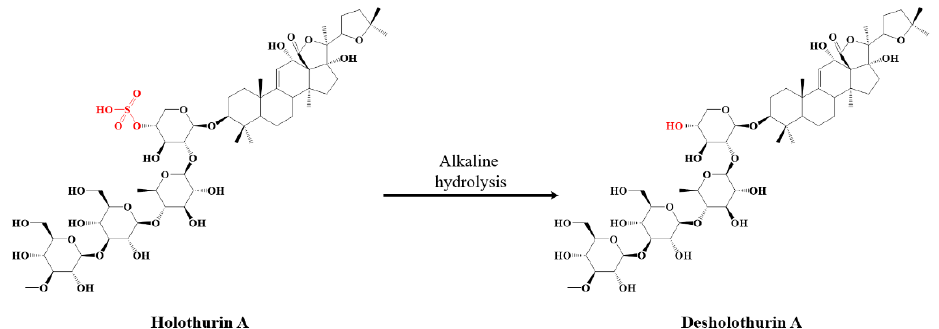
Figure 2. Hypothetical alkaline hydrolysis of Holothurin A leading to Desholothurin A by specific removal of the sulfate group.